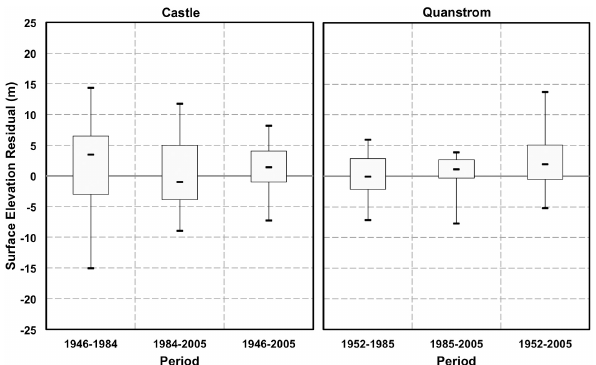
Figure 3. Box-and-whisker plots showing the maximum, interquar- tile range, median, and minimum of surface-elevation residuals of 275 checkpoints. Checkpoints are used to determine relative ac- curacy of stereo-models and bias correction for measurement of surface-elevation change of glaciers in the Castle and Quanstrom regions in three